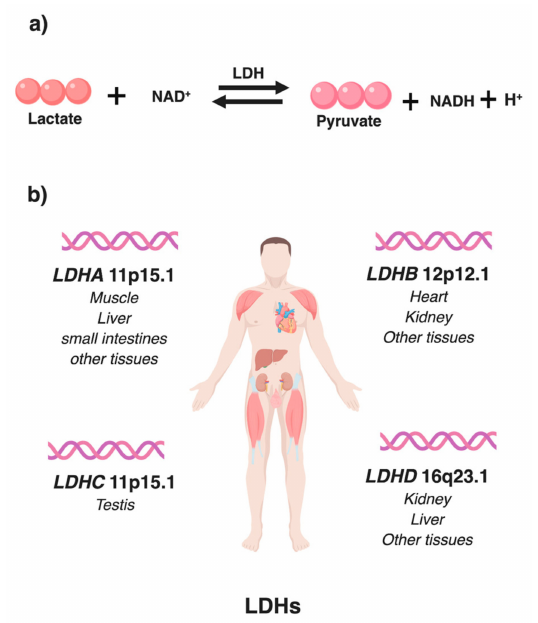
Figure 1. Lactate dehydrogenase: ( a ) Reversible conversion of pyruvate and NADH to lactate and NAD + catalyzed by lactate dehydrogenase (LDH); ( b ) Human LDH genes showing their chromosomal location and sites of predominant tissue specific